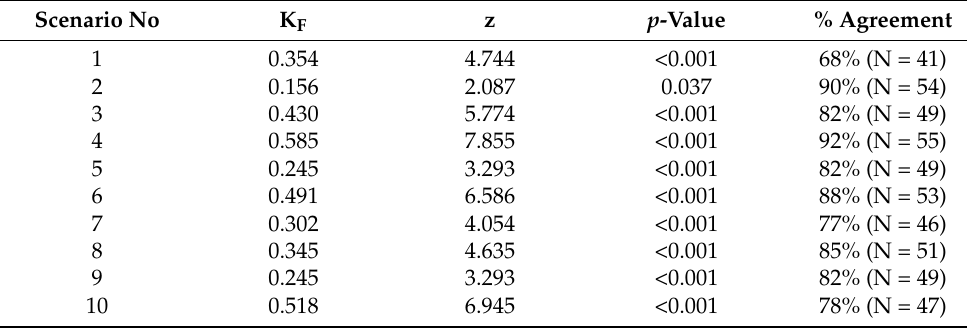
Table 4. Inter-rater reliability for HFACS-Eq Nano-Codes (60